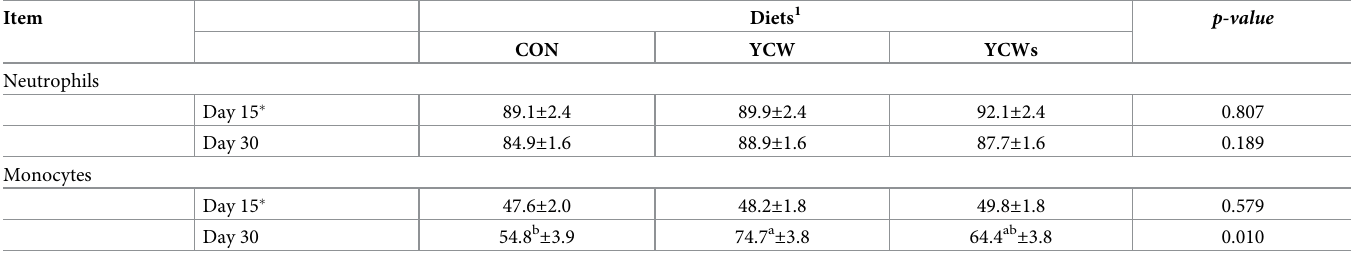
Table 10. Monocyte and neutrophils phagocytic index (% of positive cells) from dogs fed diets with the addition of different yeast cell wall preparations (mean and standard error of the mean). Item Diets 1